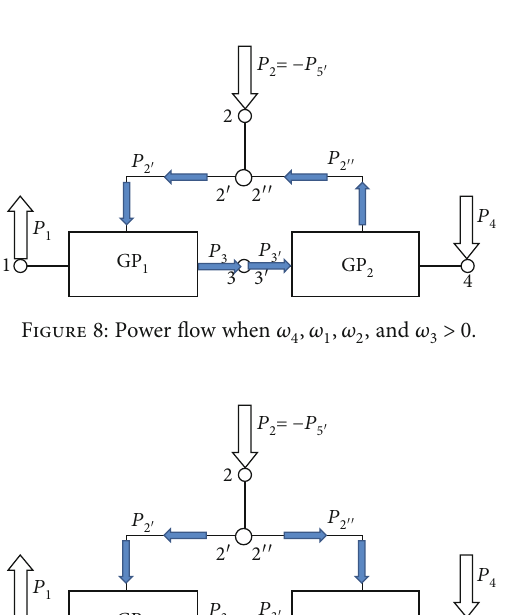
Figure 7: Input and output powers to the PGTE.